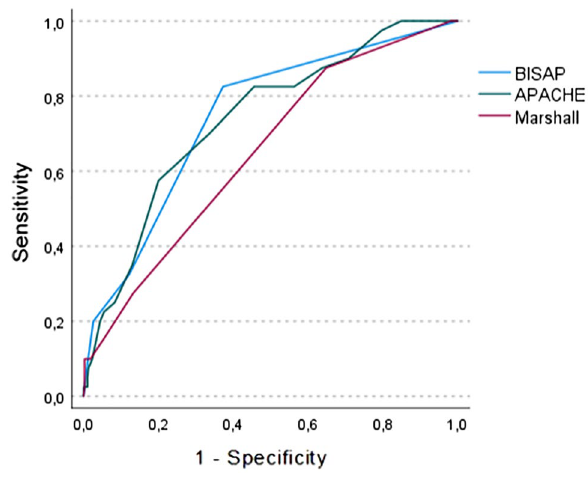
Figure 3. ROC curves for predicting surgical outcomes for different